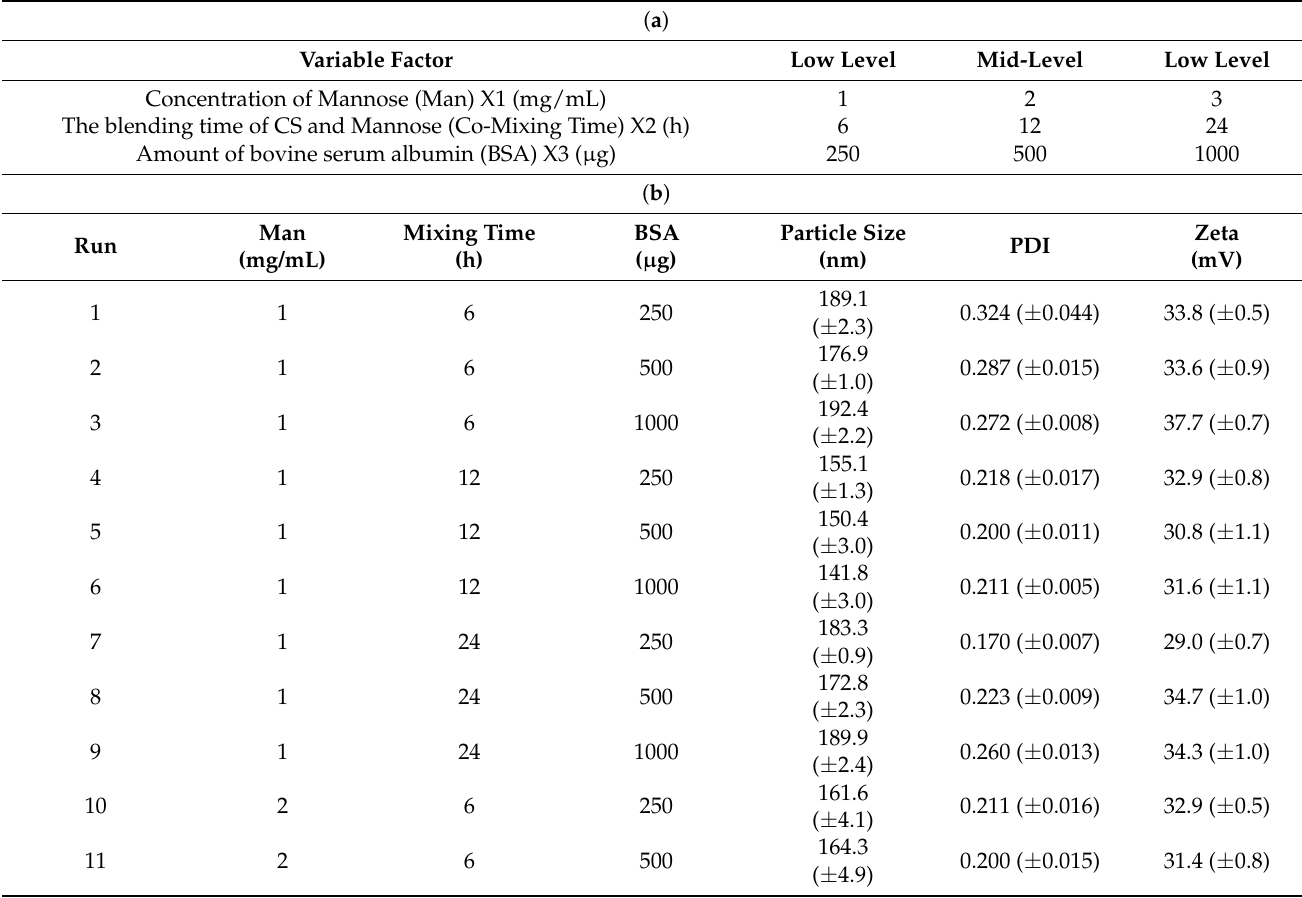
Table 5. The 2 3 full factorial design of experimental sites for Man-BSA-CS-NPs ( n = 3). (a) Values of levels of process parameters. (b) Experimental design and experimental values of particle size, PDI and zeta